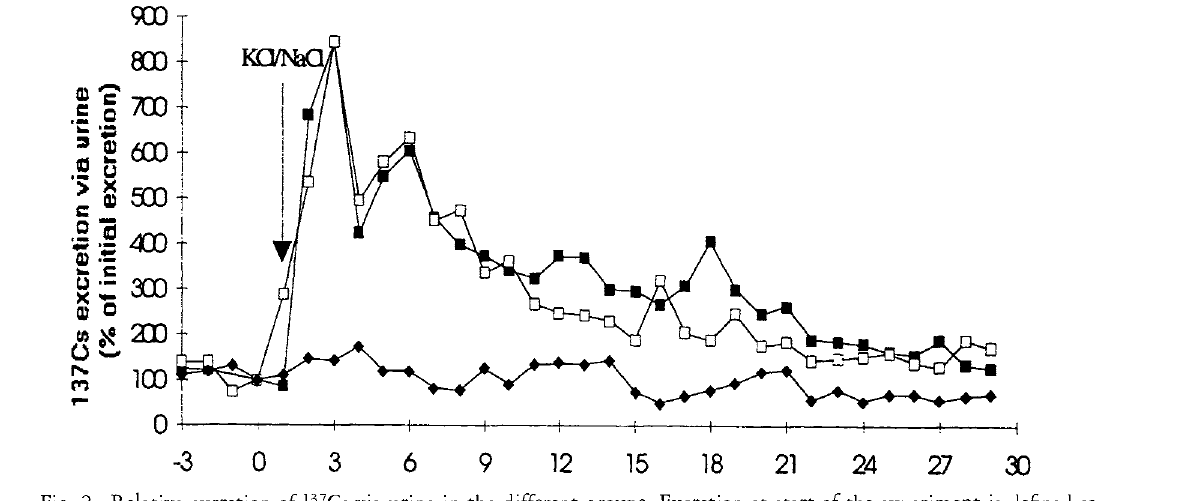
Fig. 2. Relative excretion of 137 Cs via urine in the different groups. Excretion at start of the experiment is defined as 100%. The arrow marks the start of mineral supplementation. I Potassium group, • Sodium group, • Control group.